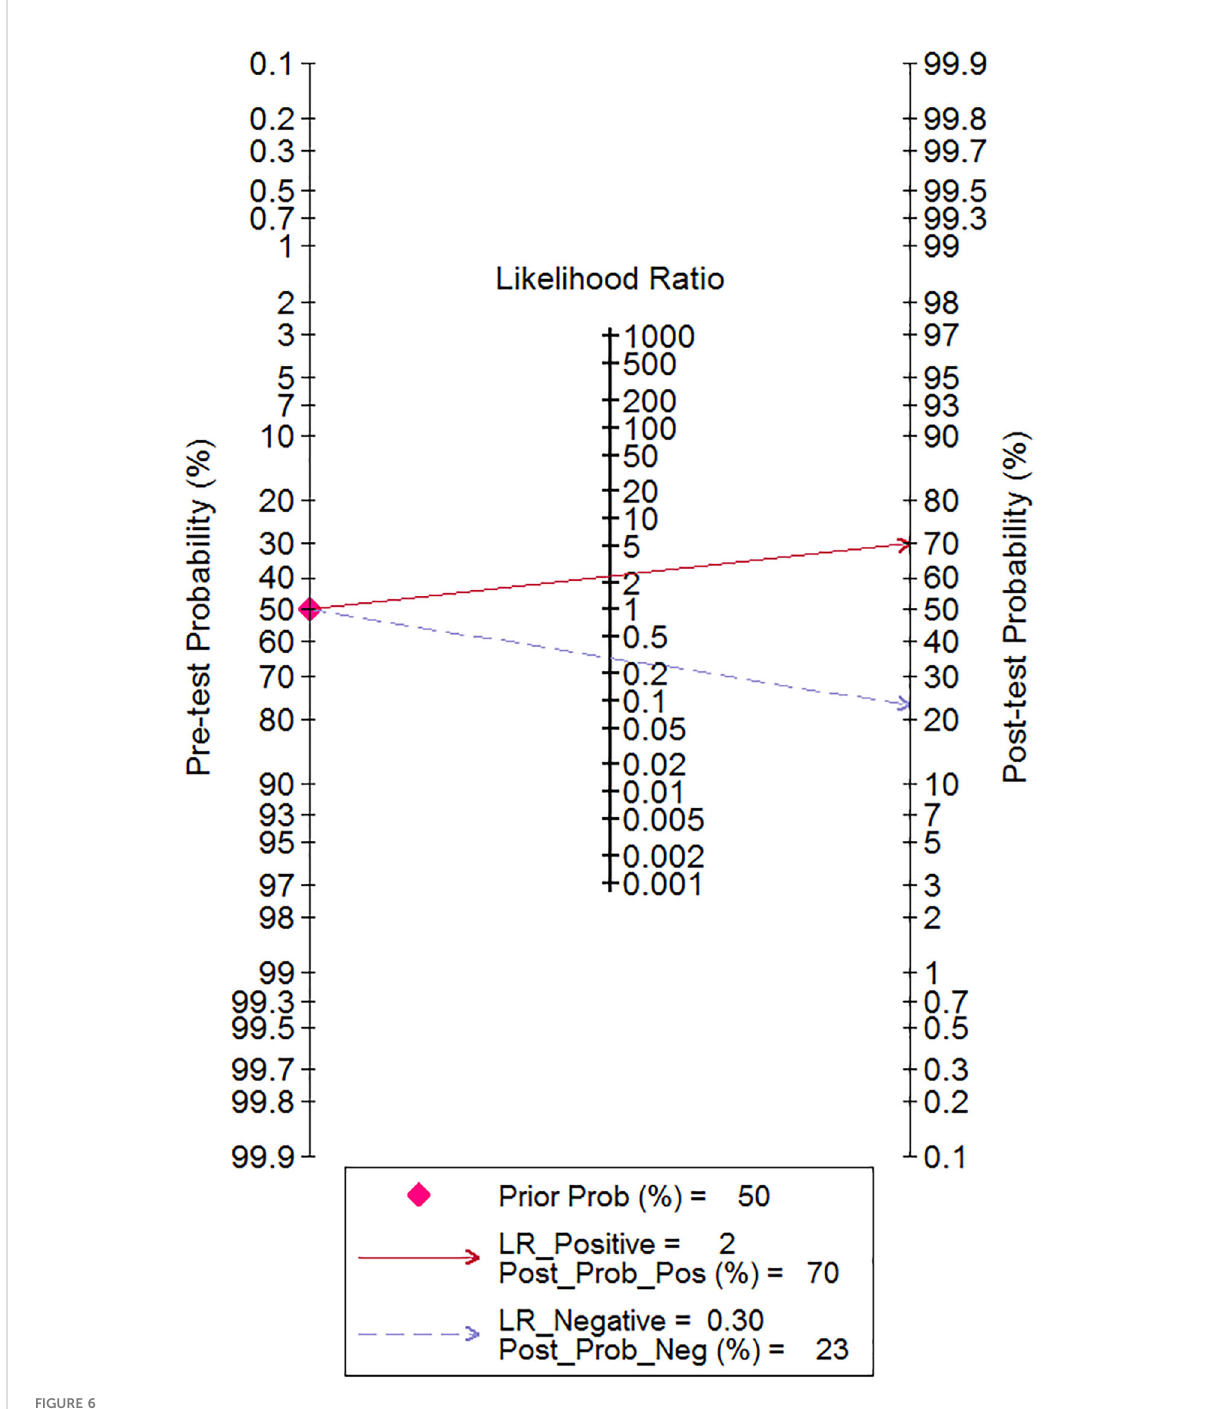
FIGURE 6 Fagan nomogram of the RDW test for diagnostic prediction of mortality in adult